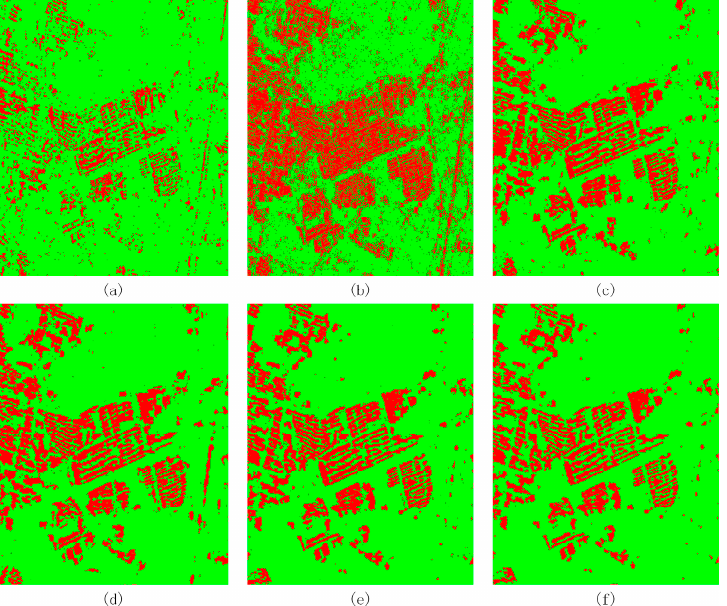
Figure 6. RADARSAT-2 image building extraction results. ( a ) Quan’s threshold extraction method; ( b ) PauliRGB and G 0 statistical texture parameters using SVM results; ( c ) RVCNN; ( d ) PFDCNN; ( e ) PauliRGB and G 0 Statistical texture parameters using CNN; ( f ) as the result of introducing superpixel constraints in ( e ). Table 3. Different methods of building extraction effects under RADARSAT-2 data.